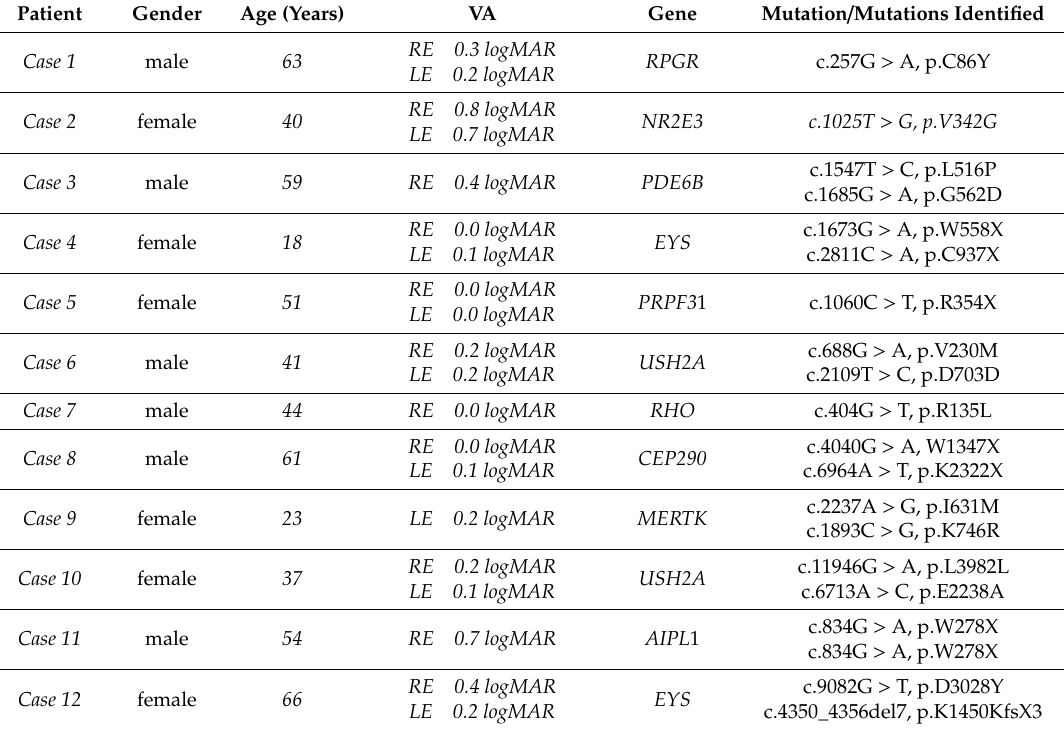
Table 1. Clinical and genetic characteristics of patients with